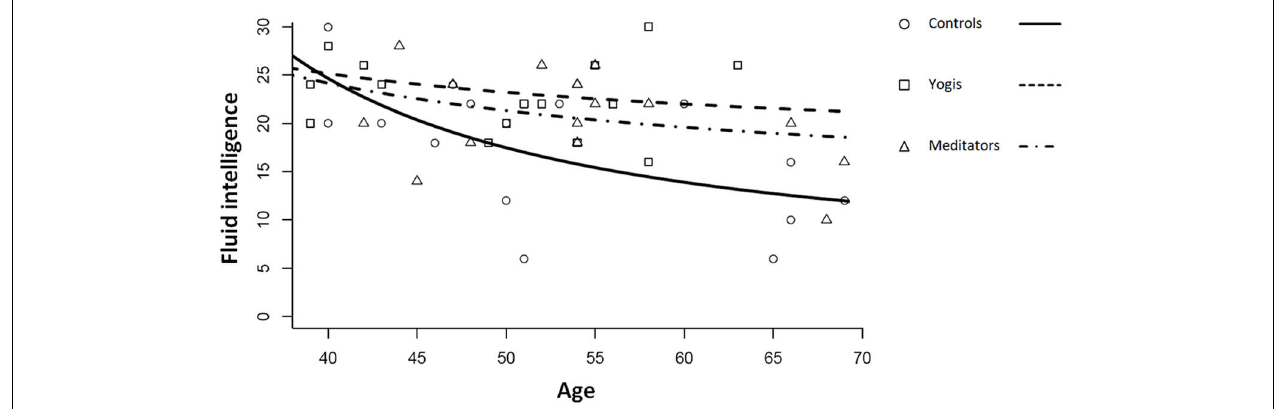
FIGURE 1 | Relation between age, measured in years and fluid intelligence measured with the Raven’s Advanced Progressive Matrices for controls, yoga practitioners, and meditators. Lines represent log-linear regression lines for the three groups following the function log(F) = A / age + log(F f )